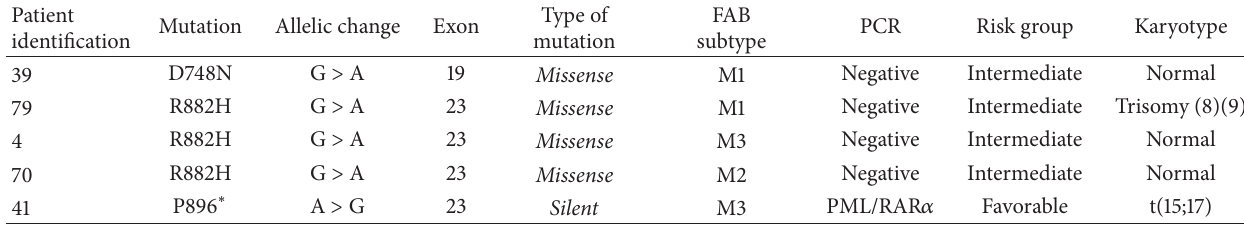
Table 4: Description of somatic mutations found in gene DNMT3A .